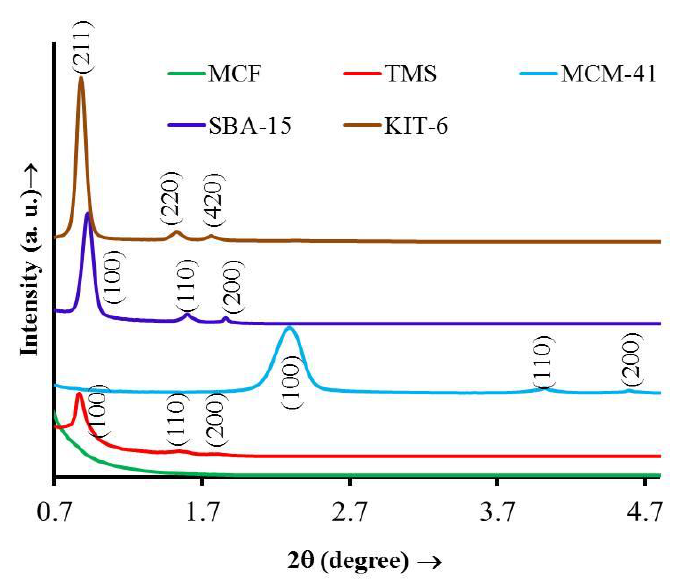
Figure 3. Small angle X-ray scattering patterns of the silica materials.